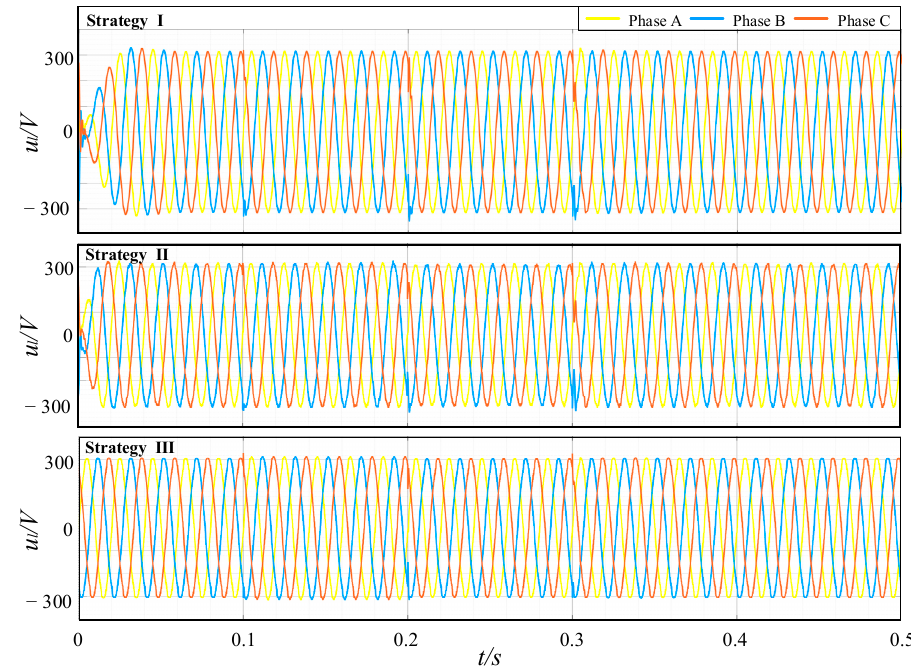
Figure 7. Load voltage under temporary swell, sag, and sudden load change conditions.